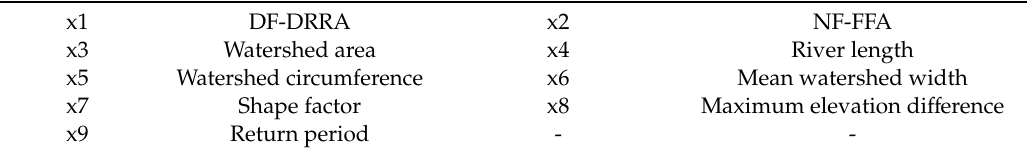
Table 1. List of explanatory